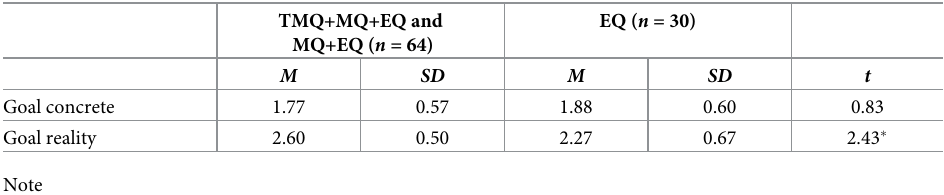
Table 4. Differences in the nature of goals depending on whether the MQ is